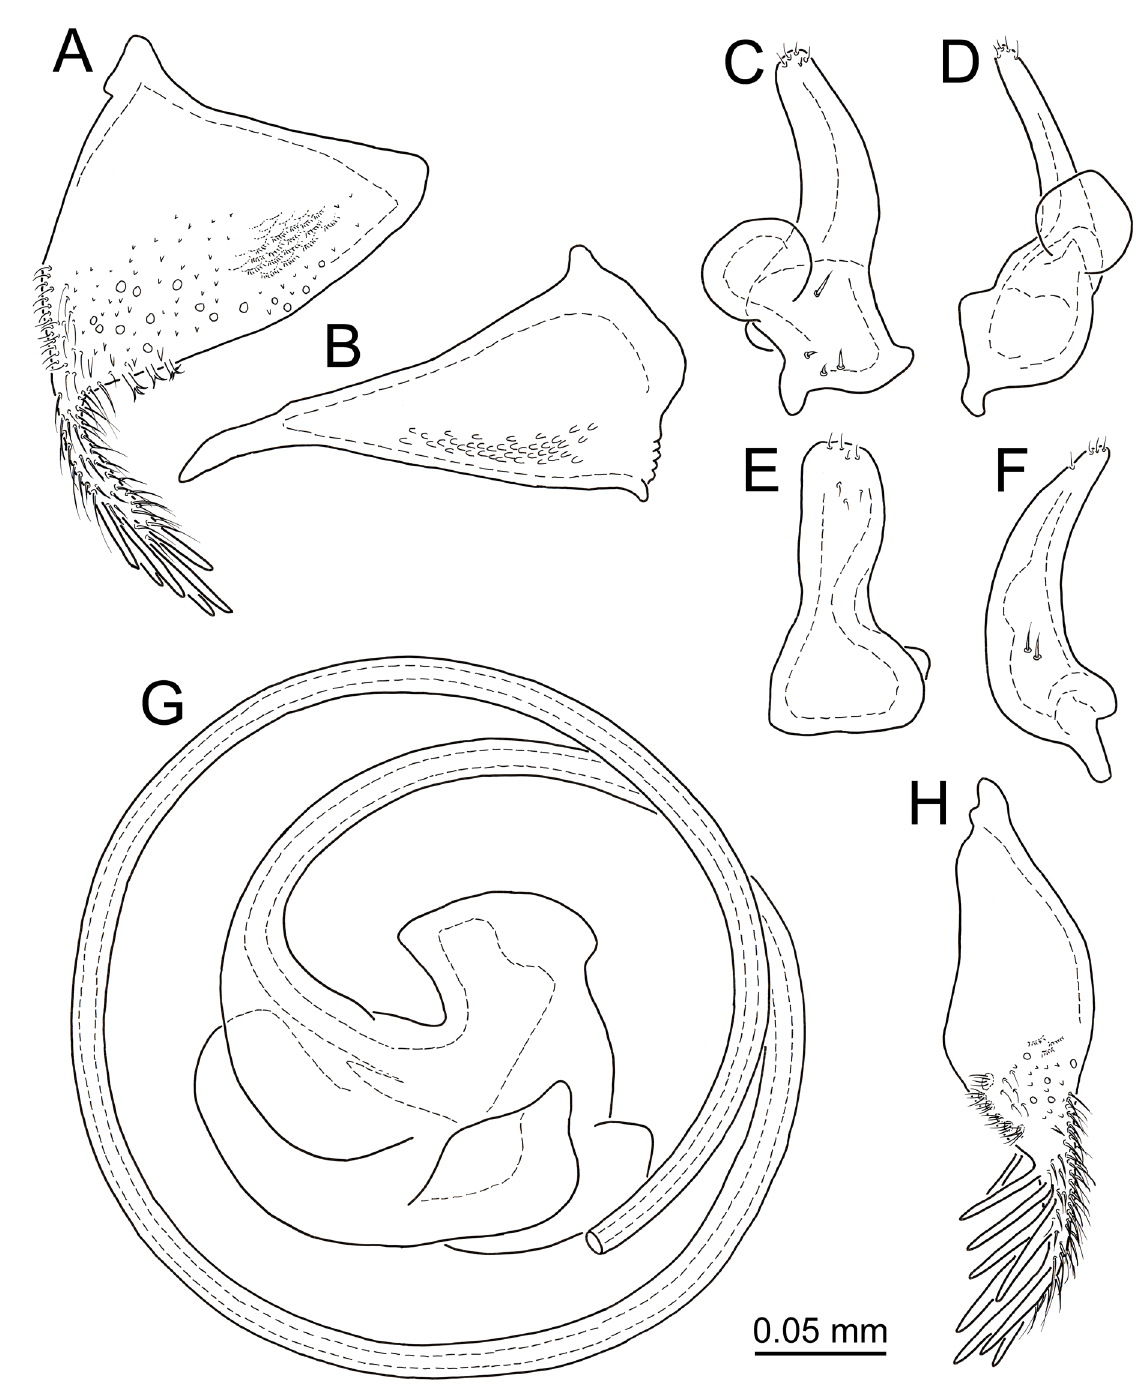
Fig. 22. Kokeshia weirauchae sp. nov., segment VIII and genitalia, paratype, ♂ (SYSBM). A, H . Left hemitergite VIII. A . Dorsal view. H . Left lateral view. B . Right hemitergite VIII, dorsal view. C‒D . Left paramere, two different aspects. E‒F . Right paramere, two different aspects. G .